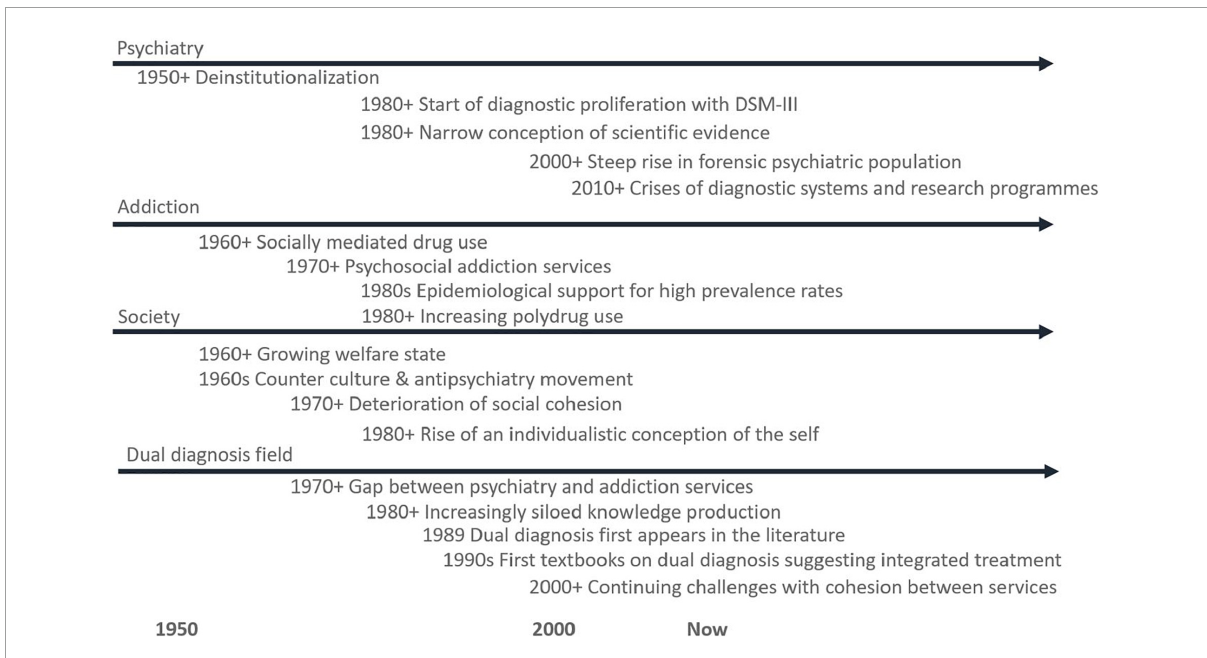
FIGURE1 A timeline of important developments leading up to the emergence of the dual diagnosis field. Most developments are difficult to pinpoint to a specific year, so timing is indicated broadly. References are found in the main